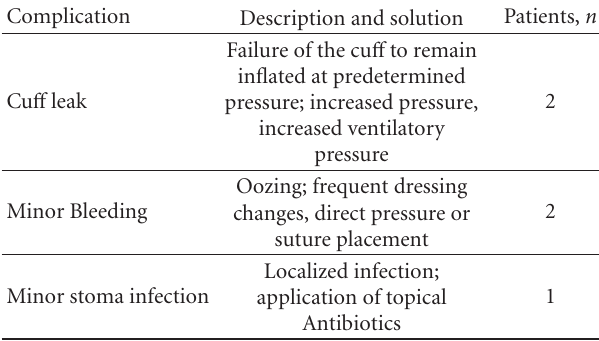
Table 2: List of